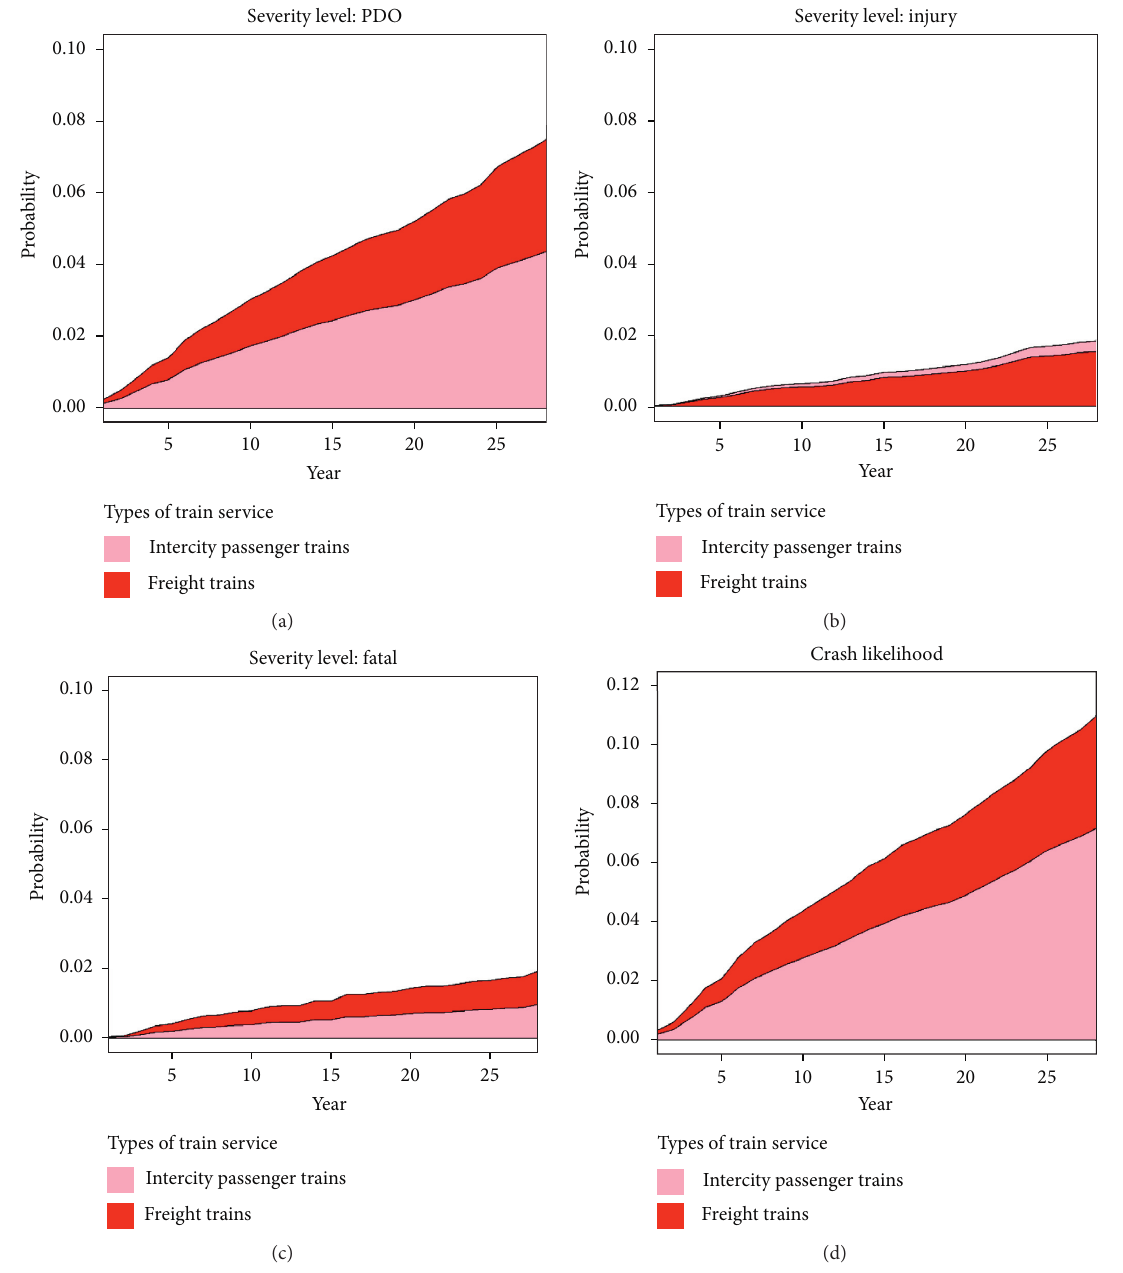
Figure 2: Cumulative probabilities of crash severity and crash occurrence for train